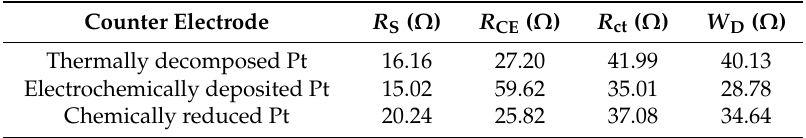
Table 2. The extract quantitative impedance parameters from the EIS Nyquist plots of the DSSCs.